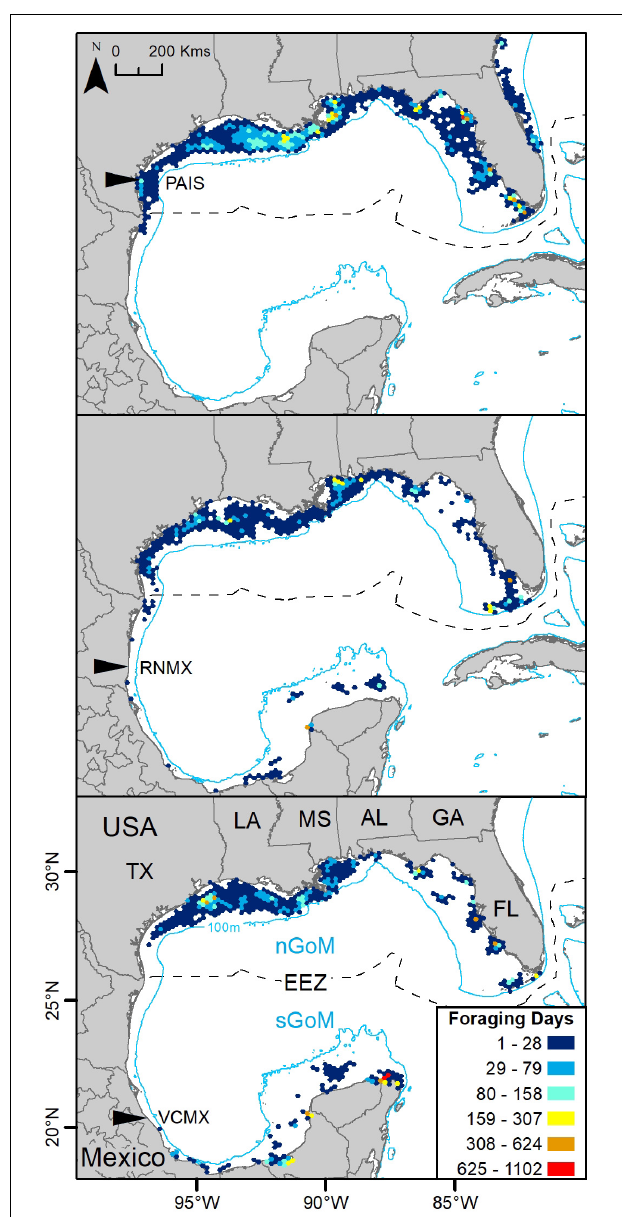
FIGURE 3 | Switching state-space model-derived foraging days for 117 post-nesting female Kemp’s ridley sea turtles tracked from the primary and major secondary nesting beaches summarized in 25 km hex-bin cells and divided by deployment location: Padre Island National Seashore, Texas, United States (PAIS); Rancho Nuevo, Tamaulipas, Mexico (RNMX); Tecolutla, Veracruz, Mexico (VCMX). The Exclusive Economic Zone (EEZ) demarcates the division between the northern Gulf of Mexico (nGoM) and southern Gulf of Mexico (sGoM). Transmitters were deployed between 2010 and